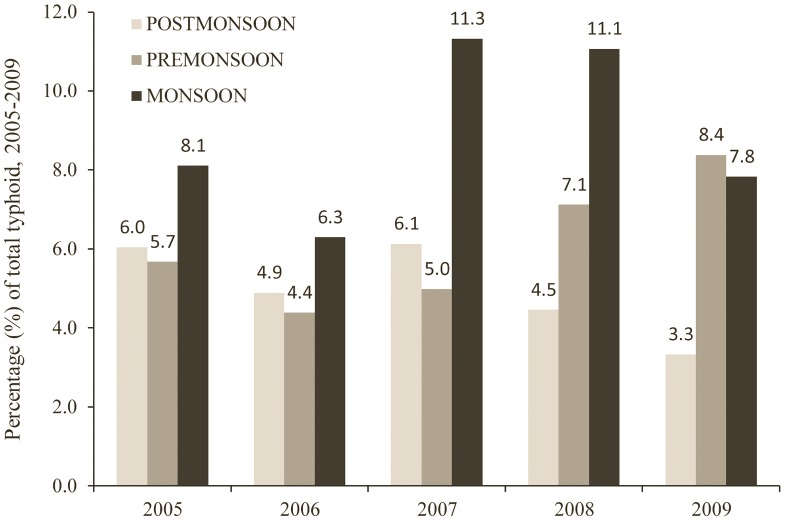
Bar graph showing percentage of seasonal typhoid cases for 2005–2009.